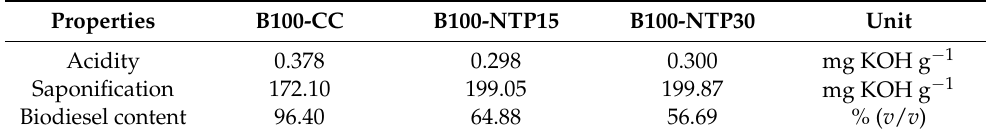
Table 2. Physico-chemical analysis results for biodiesel samples produced by CC and NTP.